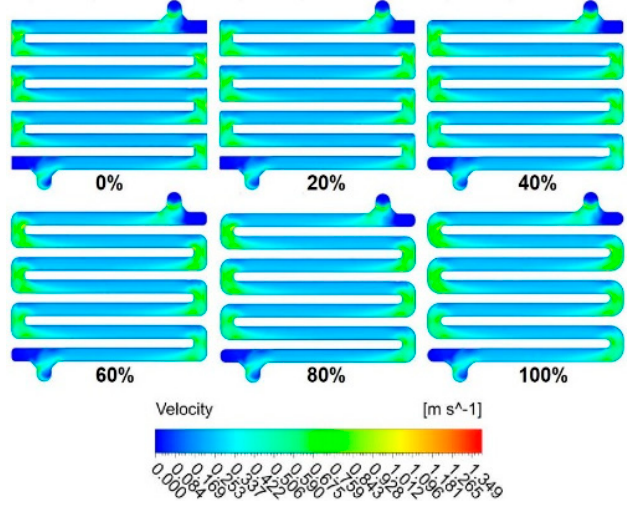
Figure 10. Velocity contour plots for the inflow through the spacer next to the membrane for all curviness cases: ( a ) 0%, ( b ) 20%, ( c ) 40%, ( d ) 60%, ( e ) 80%, and ( f ) 100%. The water flux through the module as a function of the percentage of the reference value for the curviness is shown in Figure 11. To be able to plot the other values of curviness, the percentage of the reference value as shown on the horizontal axis was defined as the value of the curviness subtracted from the 100% value for the reference, i.e., 100% corresponds to 0% curviness, 80% corresponds to 20% curviness, and so on. As can be seen, the permeate flux through the membrane slightly decreases with an increase in spacer curviness, albeit a slight decrease (from 2.81 L/m 2 h for 0% curviness to 2.73 L/m 2 h for 100% curviness). It is well acknowledged that the main parameter for predicting permeate flux is the pressure and velocity upon the membrane [38], where the pressure field depends significantly on the fluid flow pattern. Therefore, the fluid pattern played a significant role in the decrease of the permeate flux with an increased spacer curviness.